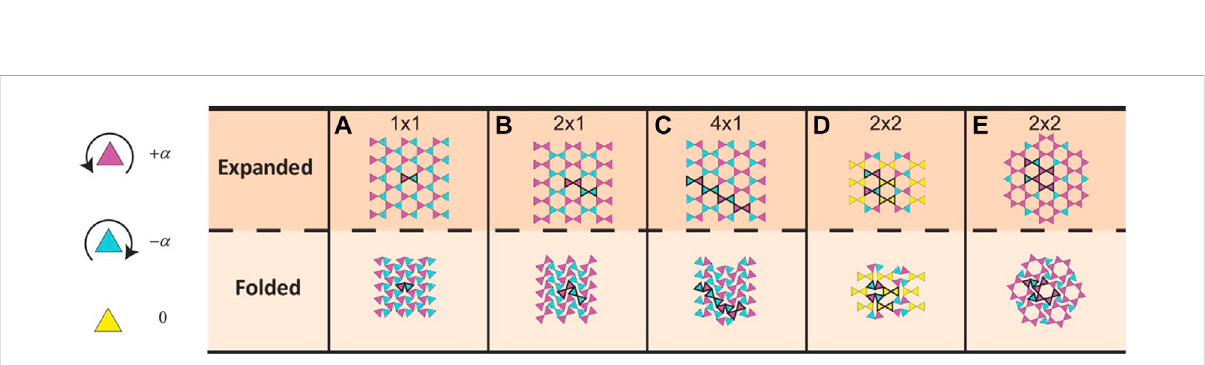
FIGURE 2 Schematic of the basic folding mechanisms in a rigid kagome network. The basic unit cell for each folding mechanism is outlined in black. The colorofthetrianglescorrespondstotheirrotation. (A) Modewithabasiccellofsize1×1; (B) Modewithabasiccellofsize2×1; (C) Modewithabasic cell of size 4 × 1; (D) Mode with a basic cell of size 2 × 2; (E) Mode with a basic cell of size 2 × 2